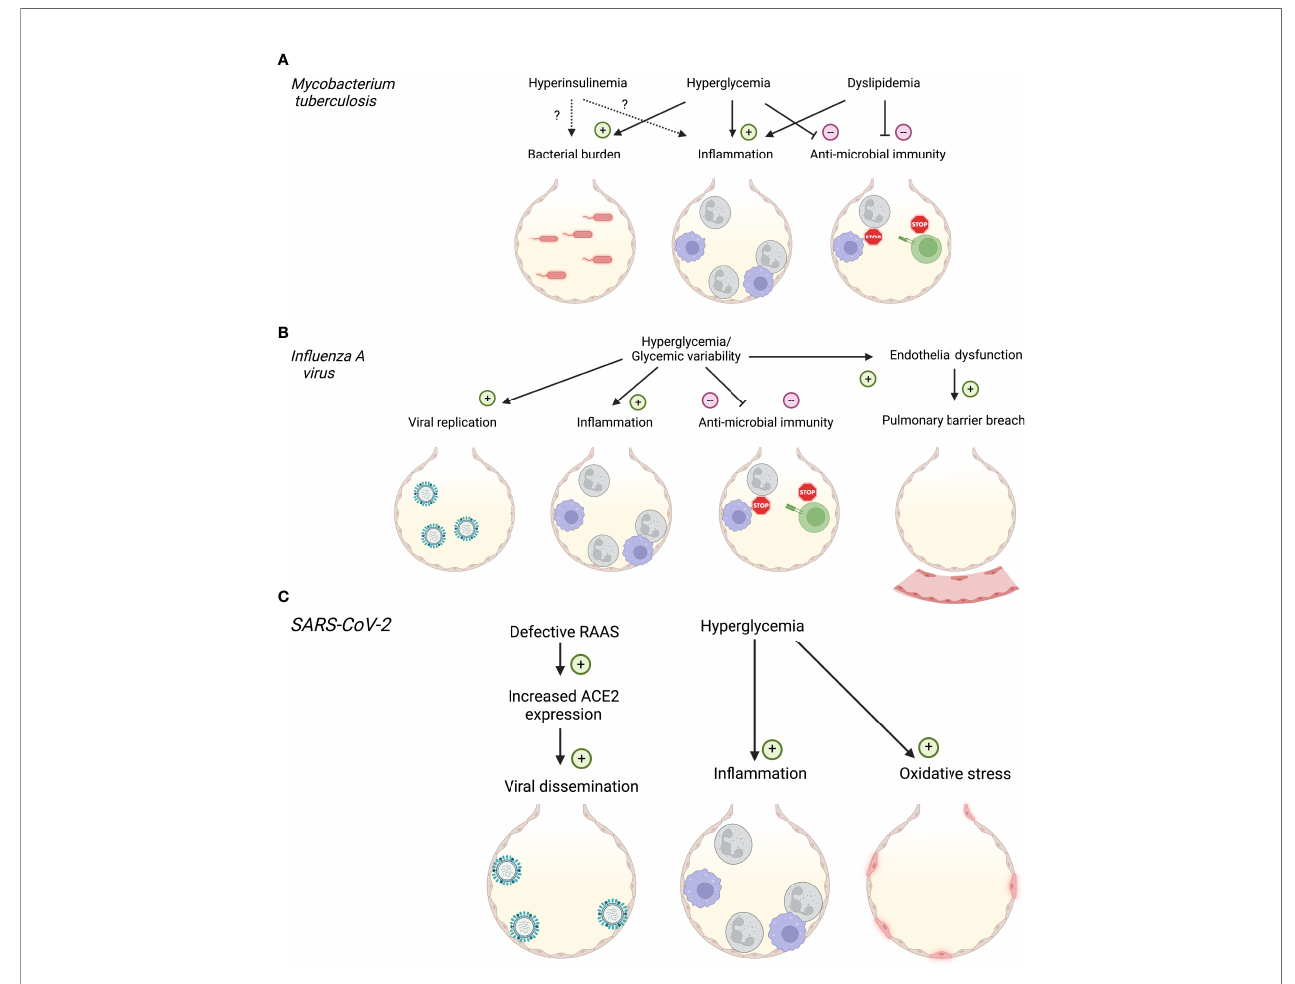
FIGURE 1 | Impact of diabetes and systemic metabolic factors on respiratory infections. (A) Impact of hyperinsulinemia, hyperglycemia and dyslipidemia on Mycobacterium tuberculosis infection. (B) Impact of hyperglycemia on In fl uenza A virus infection. (C) Impact of hyperglycemia and renin-angiotensin-aldosterone system (RAAS) dysfunction on SARS-CoV-2 infection. Created with